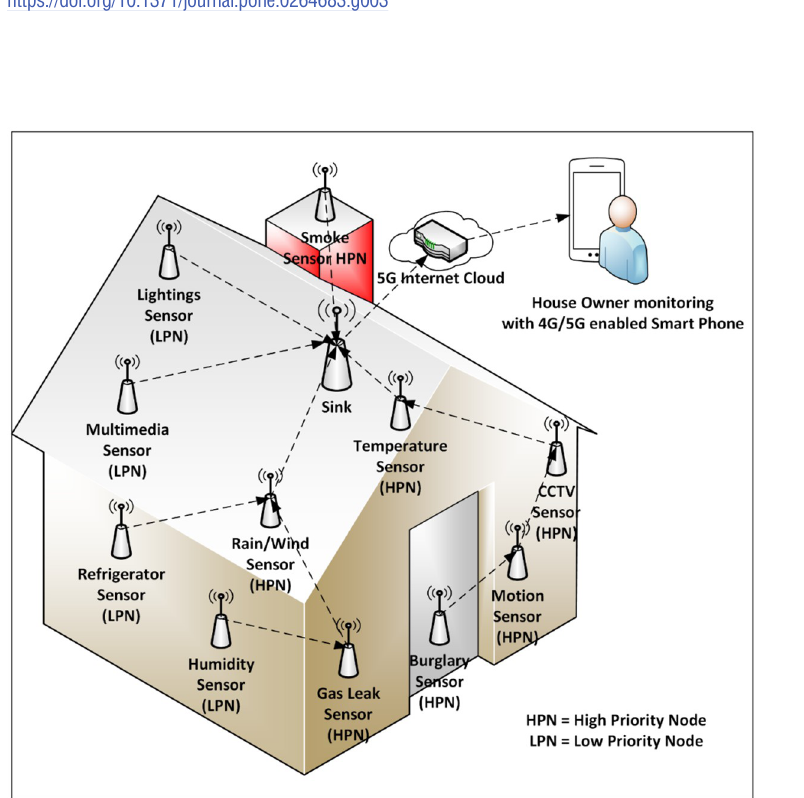
Fig 4. Application of PSPCM in smart home—Zoomed-in.